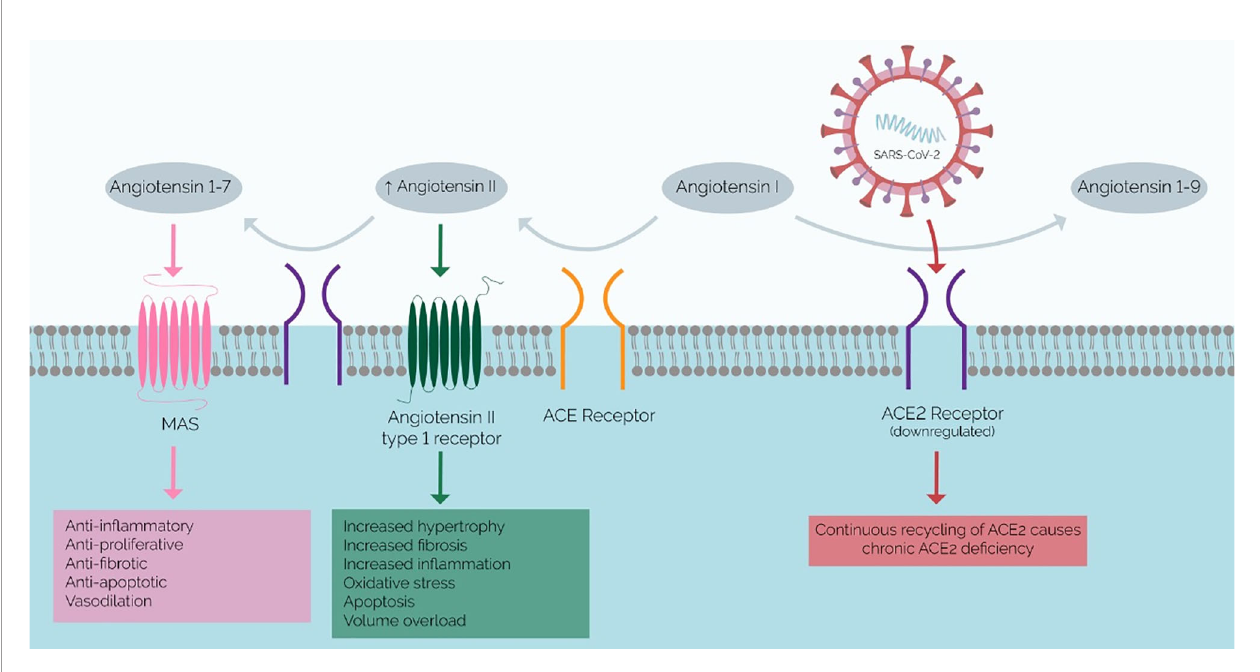
FIGURE 1 | Mechanism of SARS-CoV-2 Infection and Proposed RAAS Imbalance. ACE2 (purple) converts angiotensin II to angiotensin 1-7, which has anti- in fl ammatory effects. The chronic ACE2 de fi ciency that results in COVID-19 results in a buildup of angiotensin II and a lack of angiotensin 1-7, which promotes in fl ammation and fi brosis. Therefore, this RAAS imbalance has been implicated in the pathophysiology of the systemic in fl ammatory phenotype of severe